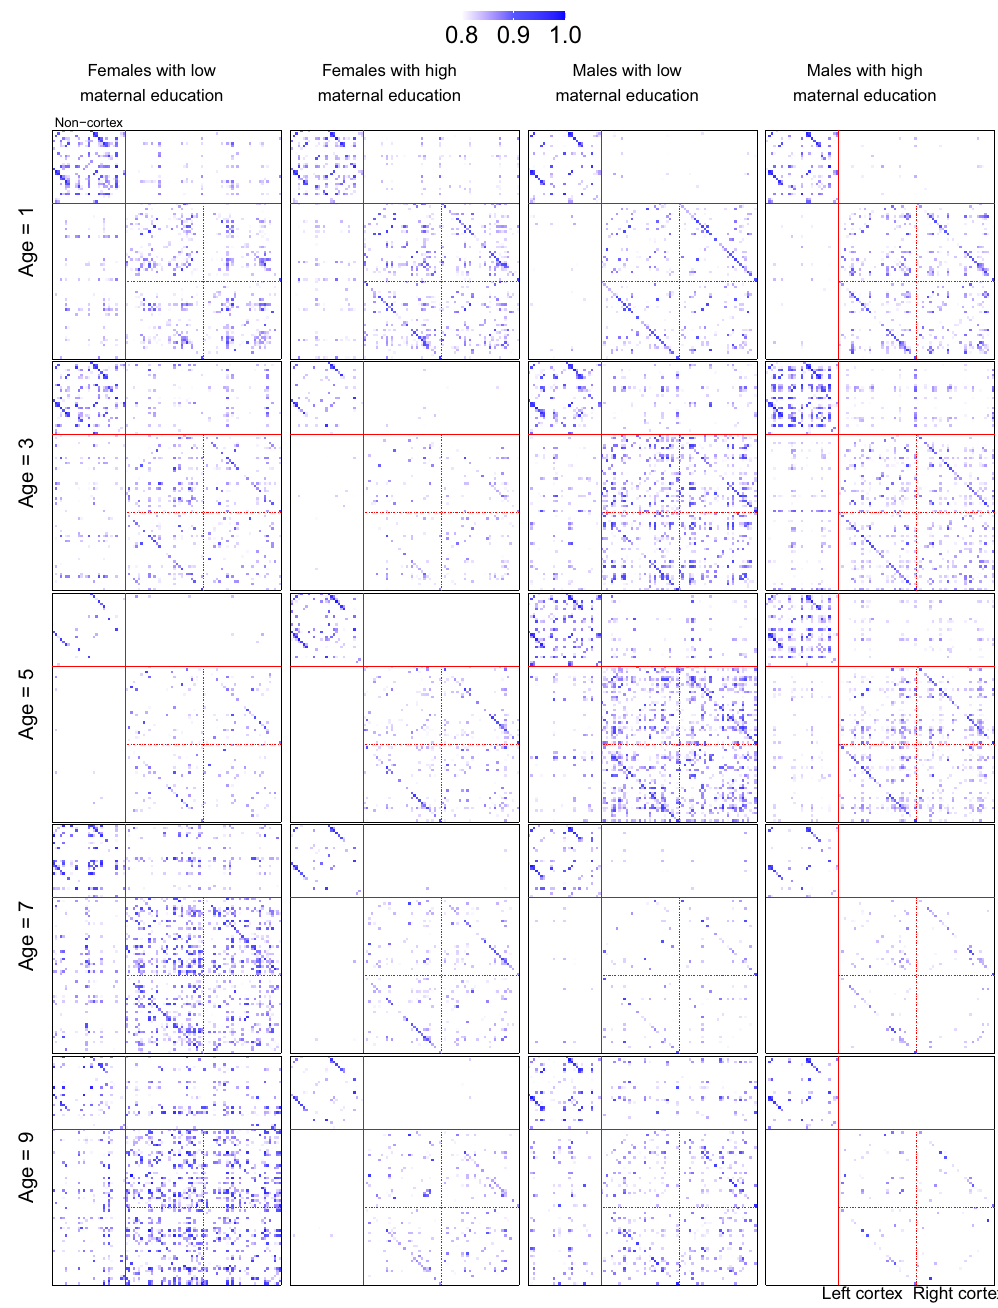
Figure 1. SCNs represented as heatmaps at ages 1, 3, 5, 7, 9 years for the four groups divided by sex and maternal education. Rows from top to bottom correspond to the five ages. Columns from left to right correspond to the four groups: females with low maternal education, females with high maternal education, males with low maternal education, males with high maternal education. The top left block contains the non- cortex regions, while the bottom right contains the left and right cortex regions; see supplementary material S1 for details of